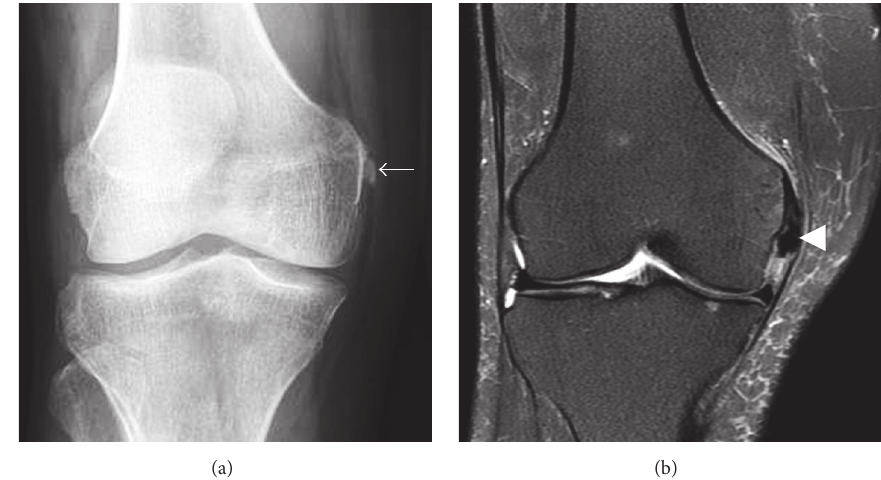
Figure 15: Calcific periarthritis of the proximal medial collateral ligament. (a) Rounded, amorphous calcification adjacent to the adductor tubercle (short arrow). (b) Calcifications (arrowhead) lie deep to the origin of the superficial band of the medial collateral ligament with mild adjacent soft tissue and minimal adjacent bone marrow